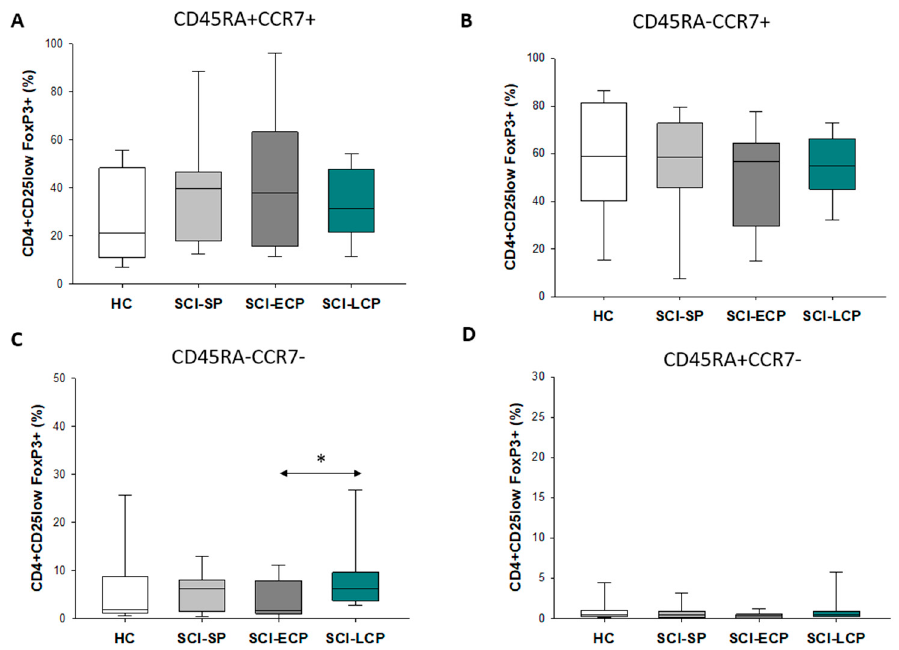
Figure 4. CD45RA and CCR7 expression in CD4+CD25low Foxp3+ Tregs. 4 subpopulations are recognized: ( A ) CD45RA+ CCR7+; ( B ) CD45RA − CCR7+; ( C ) CD45RA − CCR7 − ; ( D ) CD45RA+ CCR7 − . Healthy controls (HC); chronic SCI patients with a short period of evolution (1–5 years (SCI-SP)); chronic SCI patients in the early chronic phase (5–15 years (SCI-ECP)) and chronic SCI patients in the late chronic phase (> 15 years (SCI-LCP)). p < 0.05 (*) 3.4. Patients with a Long Period of Chronic Spinal Cord Injury Present Statistically Signi fi cant Di ff erences in Circulating CD4+ CD25+ Foxp3+ Regulatory T Cells Populations Positive for CCR5 Expression However, when we considered the expression of CCR5, we observed that there was a signi fi cant decrease with respect to HC in the expression of this marker in patients in the SCI-LCP (SCI-LCP = 29.4 [17–36.8]: HC = 43.7 [31.1–55.6], ** p = 0.006), SCI-ECP (SCI- ECP = 25.5 [20–30.8], * p = 0.04), and SCI-SP (SCI-SP = 30 [19.2–42.9], * p = 0.037) groups. These results were the same for CD4+ CD25low Foxp3+ in the case of SCI-LCP (SCI-LCP = 24 [12.8–30.3]: HC = 40.7 [26.6–51.6], ** p = 0.002), SCI-ECP (SCI-ECP = 23.4 [16.4–29.2], ** p = 0.01), and SCI-SP (SCI-SP = 26.4 [16–34.8], * p = 0.039), but not for CD4+ CD25hi Foxp3+ (Fig- ure 5A–C).